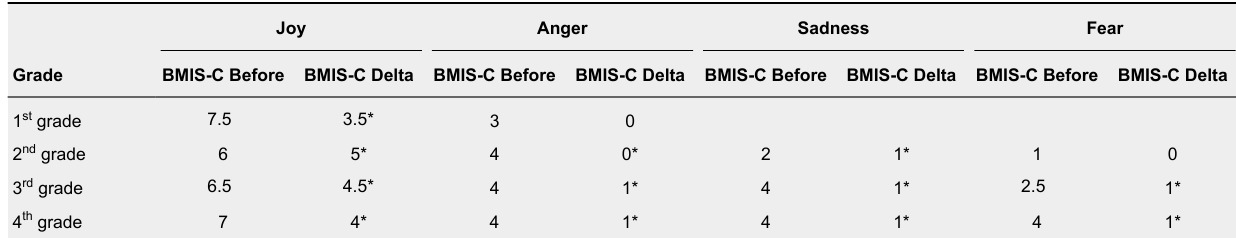
Evolution of the Emotional State Before and After the Joy Induction, According to the Student’s Grade and the Induced Emotion Joy Anger Sadness Grade